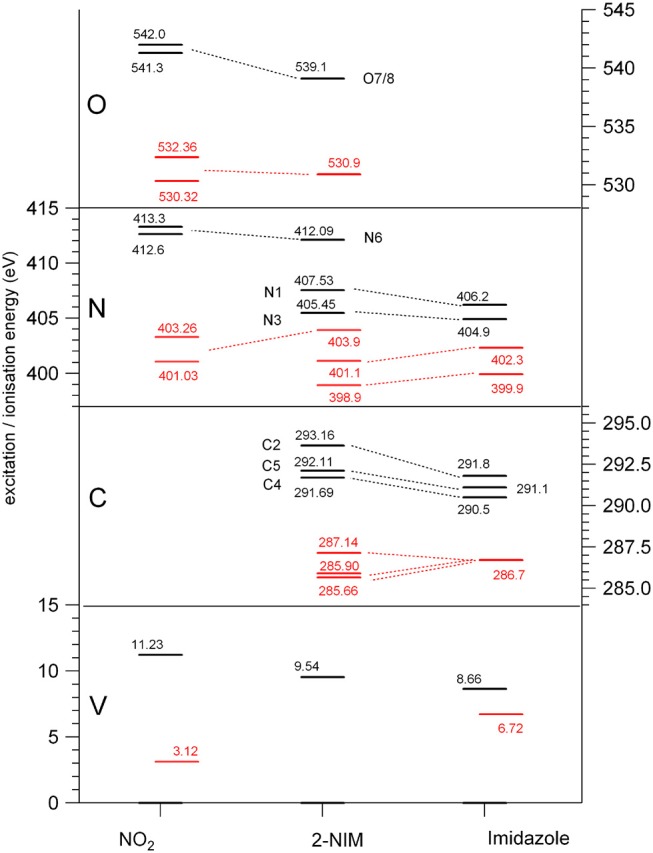
Diagram of the binding energies (black) and of the lowest (LUMO) excitation energies (red) at the O, N, and C K edges and at the valence shell (Kimura, 1981; Schwell et al., 2008; Cartoni et al., 2018), for nitrogen dioxide (Davis et al., 1973; Au and Brion, 1997; Jayawardane et al., 2001) (left), 2NIM (center) and imidazole (right) (Apen et al., 1993; Thomason et al., 2015) molecules.